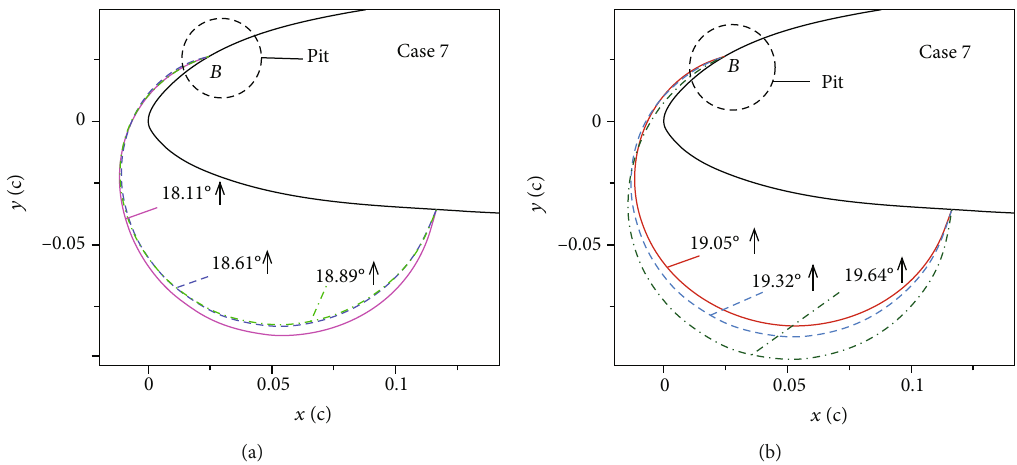
Figure 30: Comparison of ILE shapes at di ff erent angles of attack upstroke in airfoil frame of reference for Case 7.